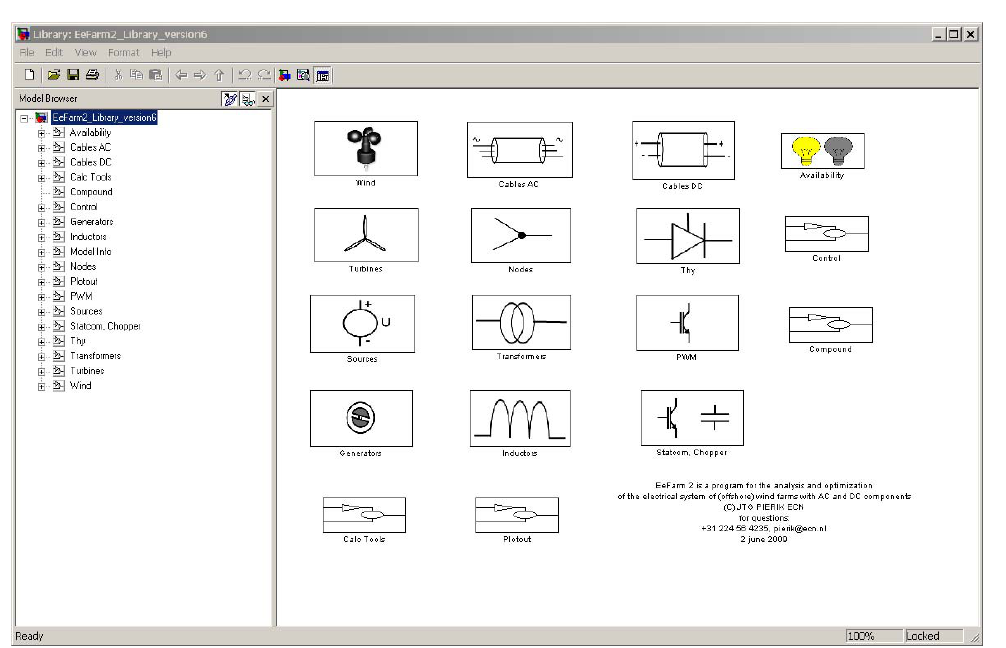
Figure 1 . EeFarm model